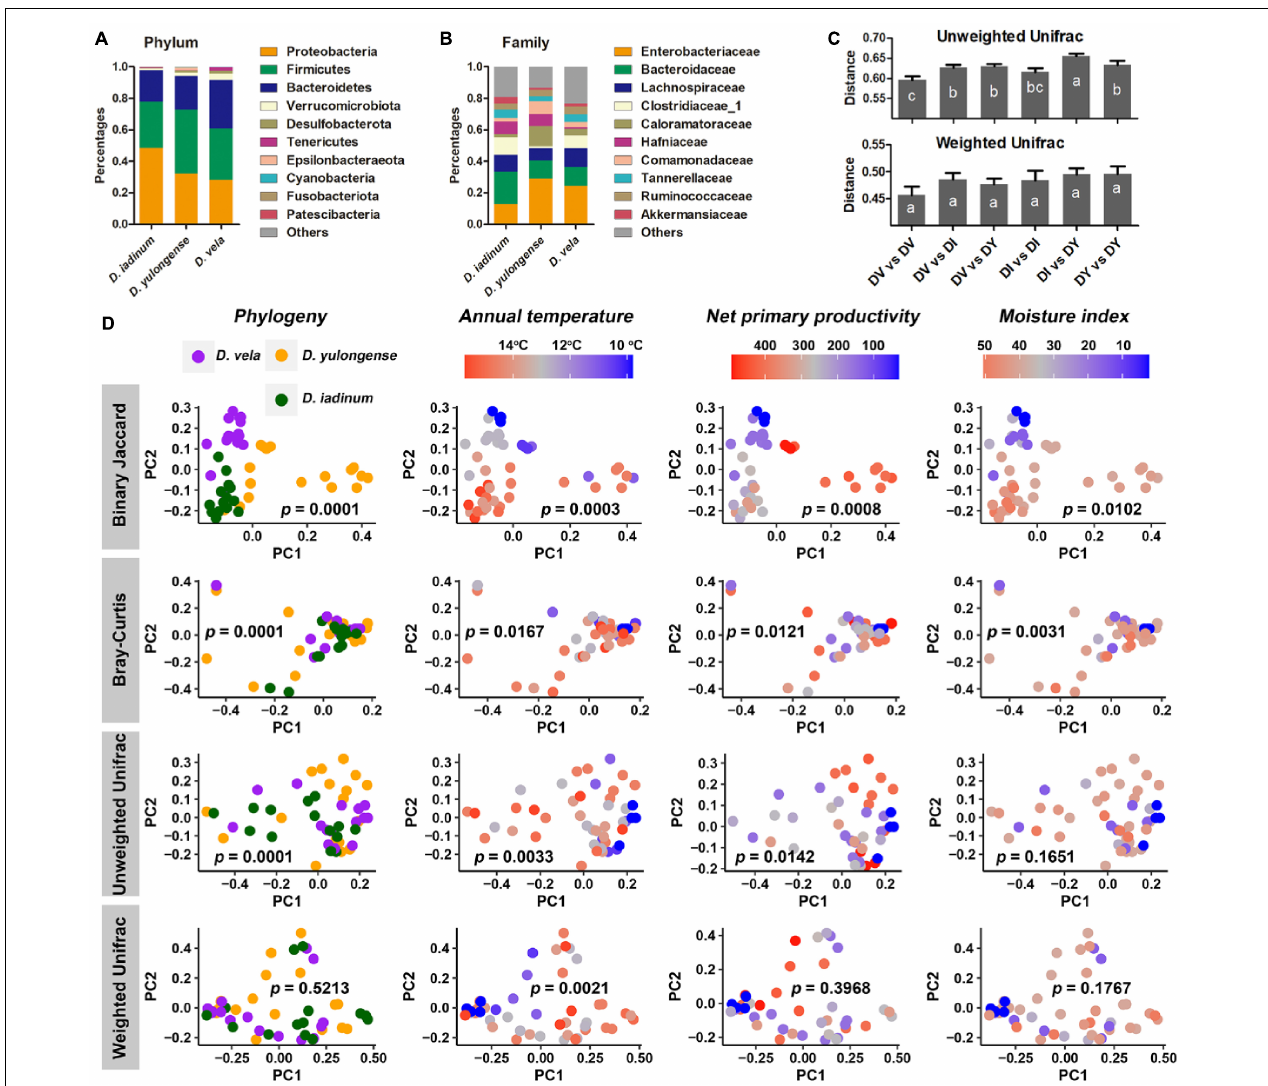
FIGURE 4 | Influences of host phylogeny and climatic factors on the gut bacterial community structure of mountain dragons. (A,B) Composition of the microbiome at phylum (A) and family (B) levels. (C) Interspecies distances of the gut microbiome. (D) PCoA scatter plots presenting the significance of phylogeny and climatic factors on variations in the gut microbiome (interpopulation analyses across species). The p -values of PERMANOVA were